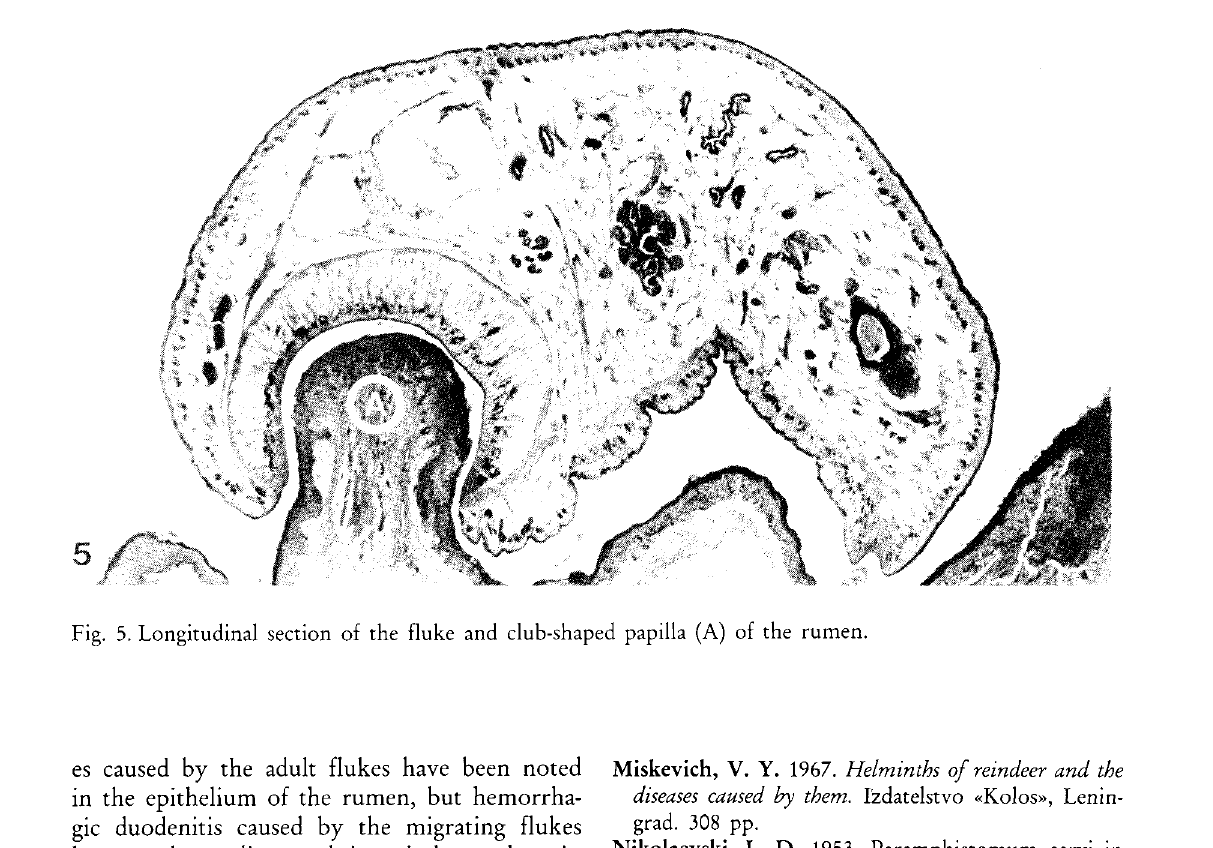
es caused by the adult flukes have been noted in the epithelium of the rumen, but hemorrha gic duodenitis caused by the migrating flukes has not been diagnosed in reindeer calves in